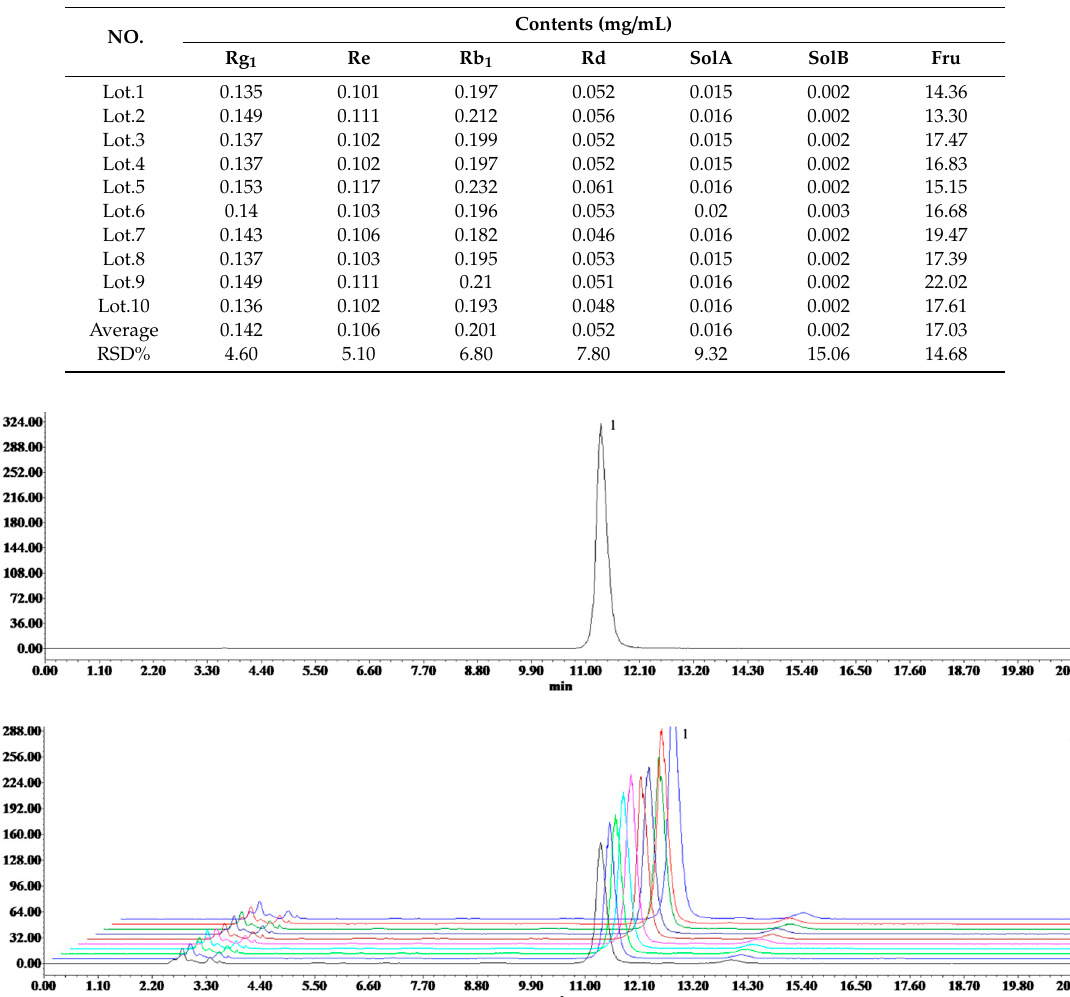
Table 2. Contents of the seven compounds in the 10 batches.